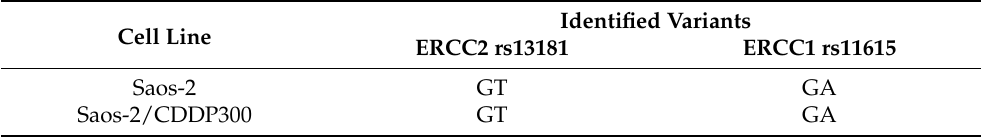
Table 3. DNA single nucleotide polymorphisms with genotype and amino acid changes in Saos-2 cisplatin (CDDP)-resistant variants compared to their parental cell line, which were identified by both multimodal targeted next generation sequencing (mmNGS) and TaqMan